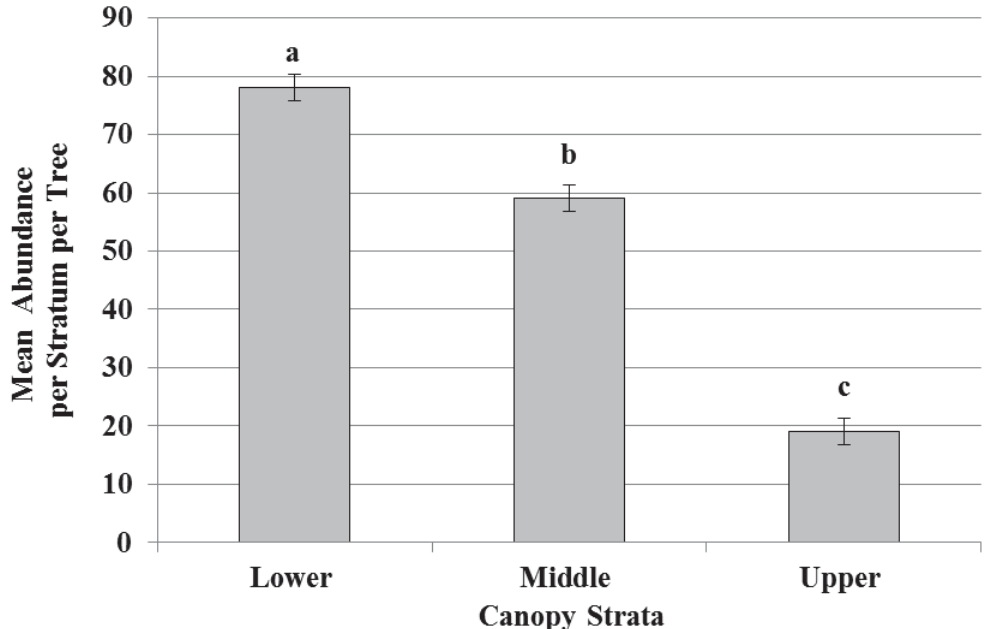
Figure 1. Mean abundance (mean number of individuals ± SE) for each stratum. Means ( n = 6) with different letters are significantly different (LSD test; p < 0.05).